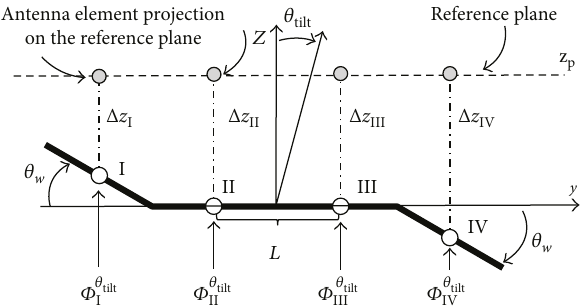
Figure 3: Representation of the pattern recovery with our technique for a deformed 4 × 4 array whose beam is tilted of θ tilt : the reference plane is chosen as if the array were operating in broadside , and θ tilt correcting phase shifts Φ n (di ff erent with respect to the one given from the PM) are introduced in the n th element (see Section